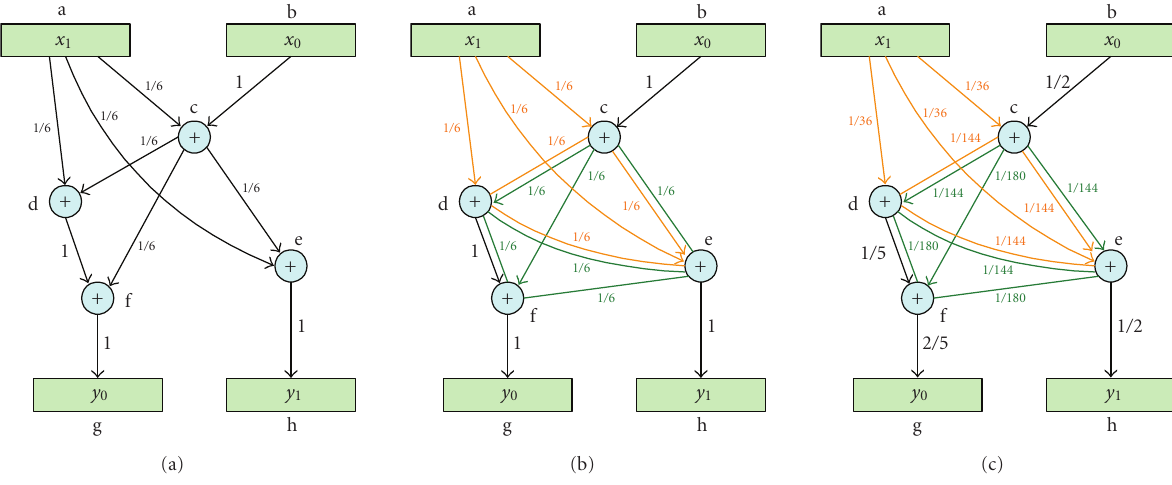
Figure 9: Calculating the edge weights according to modified CSE algorithm: (a) Divisors that are used multiple times are shown as multi- terminal nets with edge weights based on equation (14). (b) A clique is formed with recalculated weights using equation (16). (c) Final edge weights are calculated using mutual contraction using